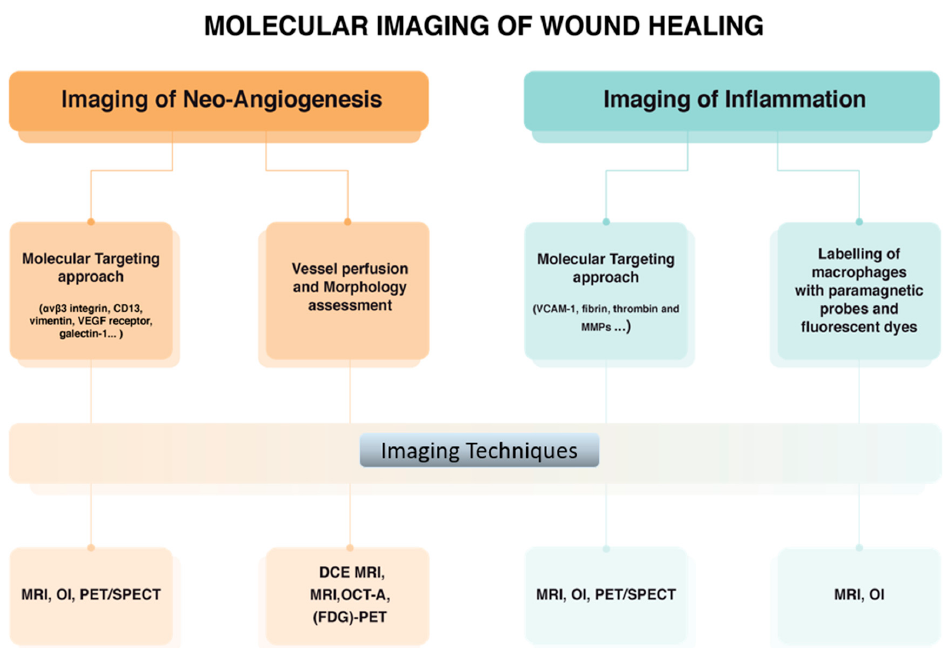
Figure 5. Molecular imaging approaches used for monitoring corneal wound healing. (MRI: magnetic resonance imaging, PET: positron emission tomography, SPECT: single photon emission computed tomography, CT: ultrasound imaging and computed tomography, DCE: Dynamic Contrast Enhanced, FDG: 18 F-Fluorodeoxyglucose, OI: Optical imaging, OCT-A: Optical coherence tomography angiography).